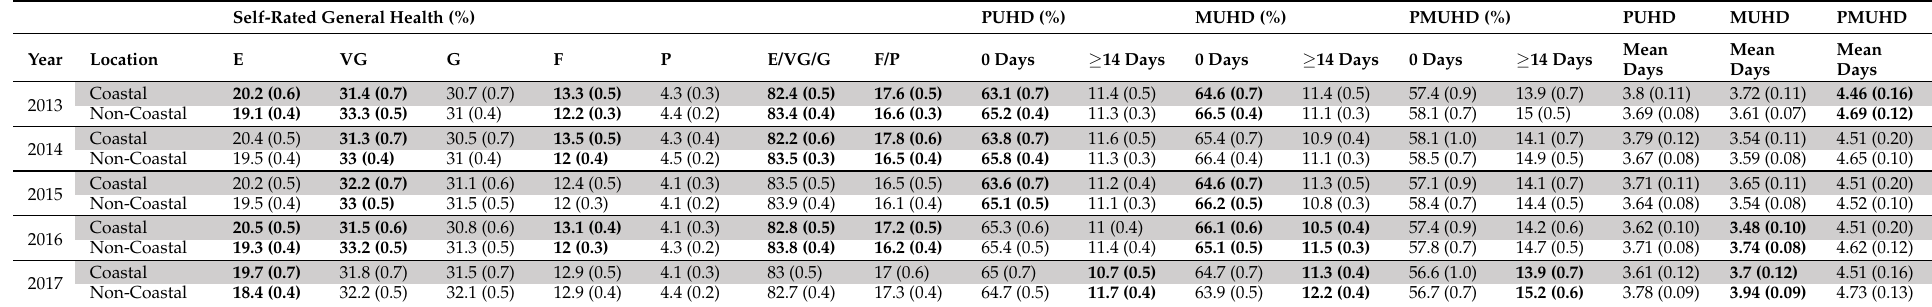
Table 2. Comparison of all coastal vs. all non-coastal MMSAs: Mean self-rated general health and unhealthy days. (See table notes for